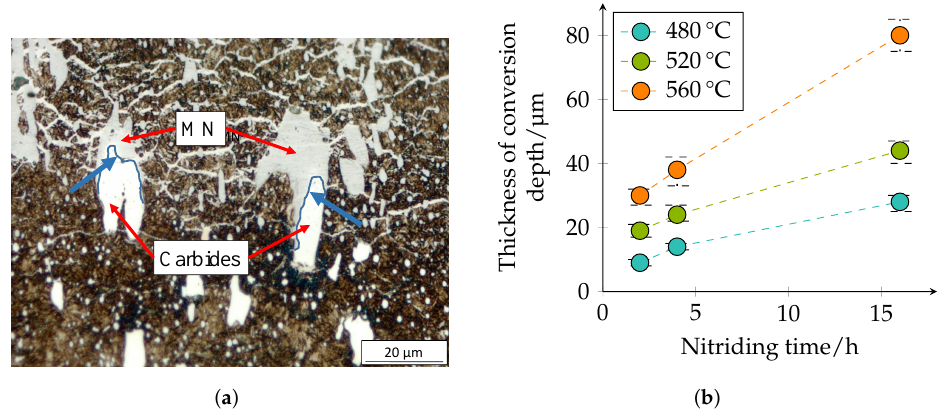
Figure 11. Thickness of the conversion depth of the carbides/nitrides depending on the tem- perature and duration of plasma nitriding measured light-optically. ( a ) Conversion depth of the carbides/nitrides measured light-optically. Blue arrows mark exemplarily the measuring points. ( b ) Thickness of the conversion depth of the carbides/nitrides.